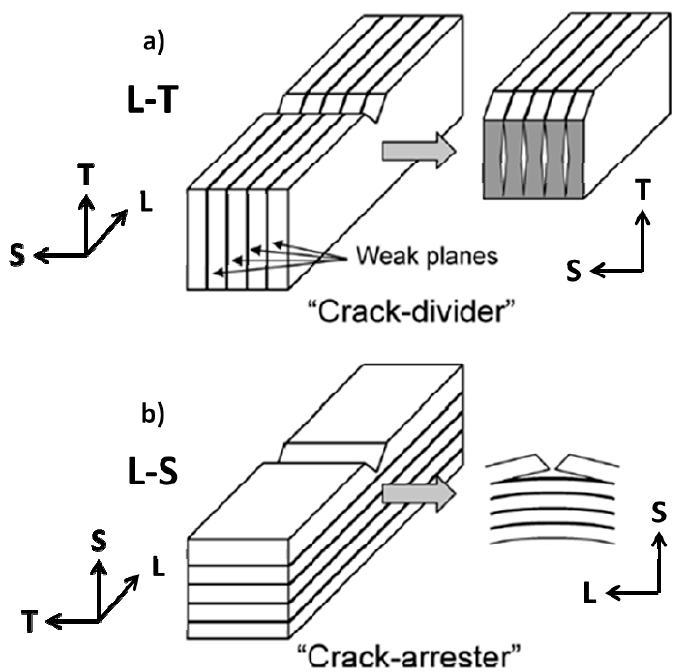
Figure 1. Schematic illustration showing the two most common splitting geometries for the ( a ) L-T and the ( b ) L-S oriented specimen machined from a hot-rolled material [13].